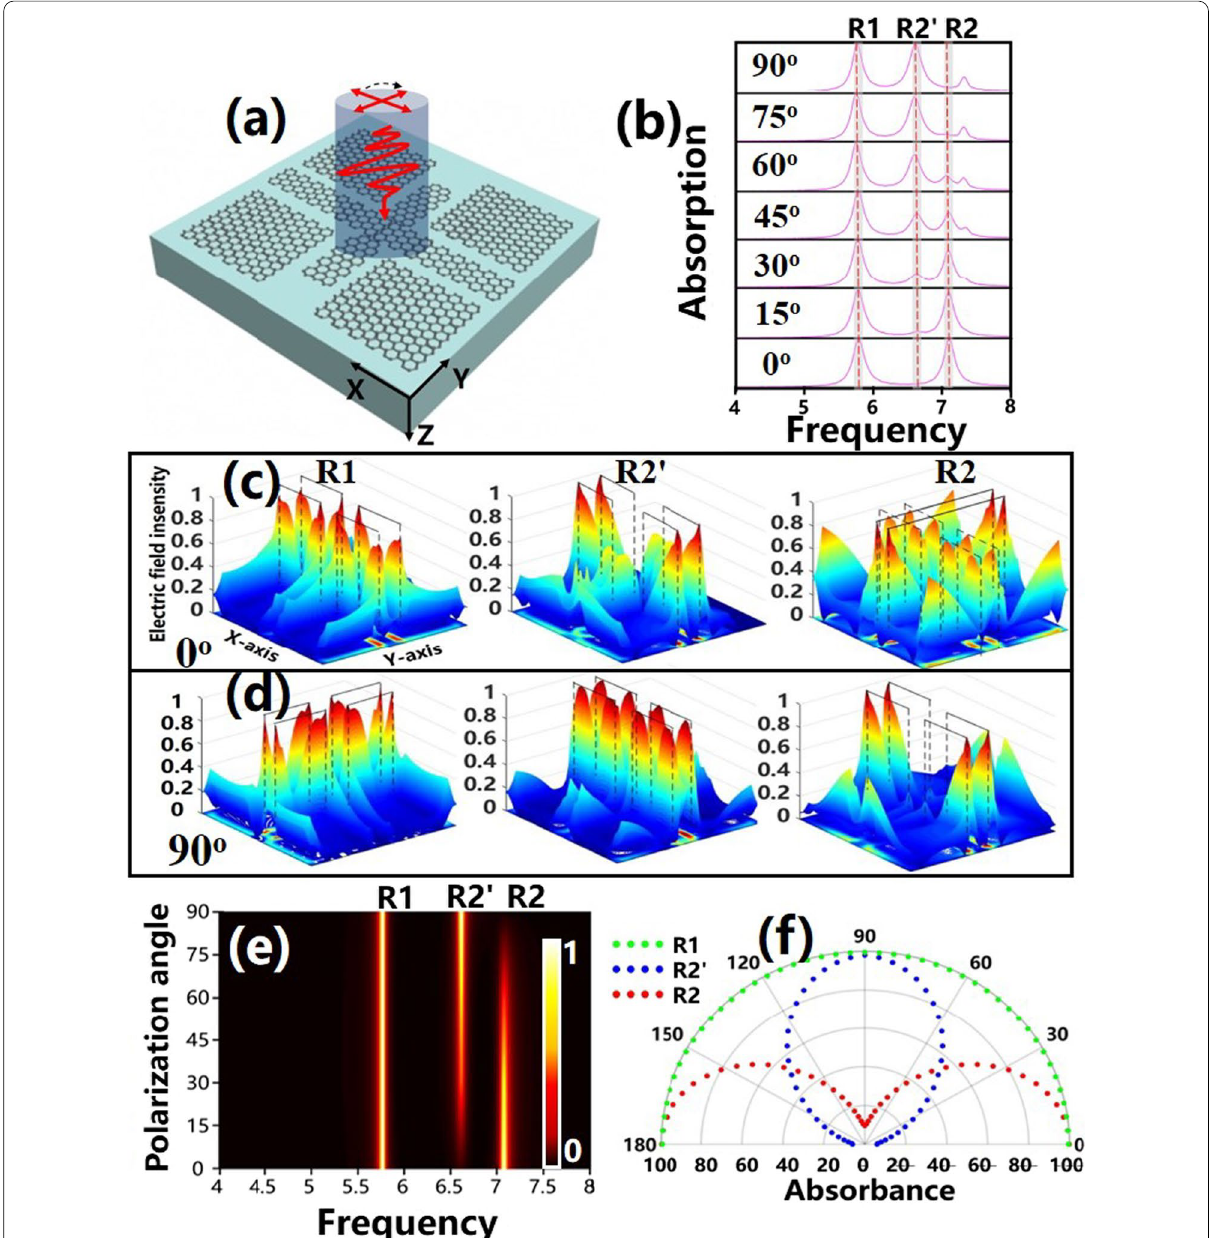
Fig. 6 a Single-layer graphene patterned unit structure. b Absorption spectrum with polarization angle varying from 0° to 90°. c , d The electric field around the structure at f R1 , f R2’ and f R2 with polarization angles being 0° and 90°, respectively. e Three-dimensional diagram of absorption with polarization angle and frequency. f Polar coordinates diagram variation of the polarization angle from 0° to